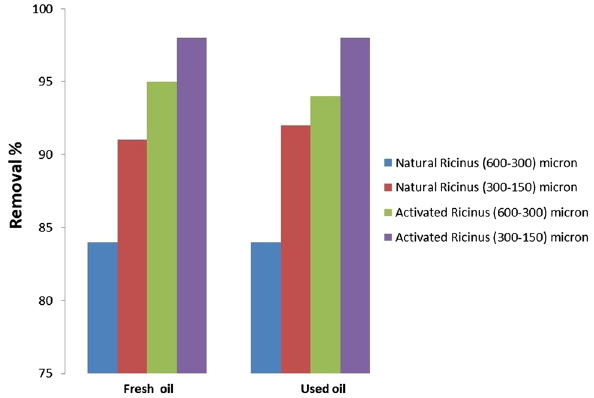
Fig. 7 Effect of RC particle size on the removal efficiency of oil emulsion by RC